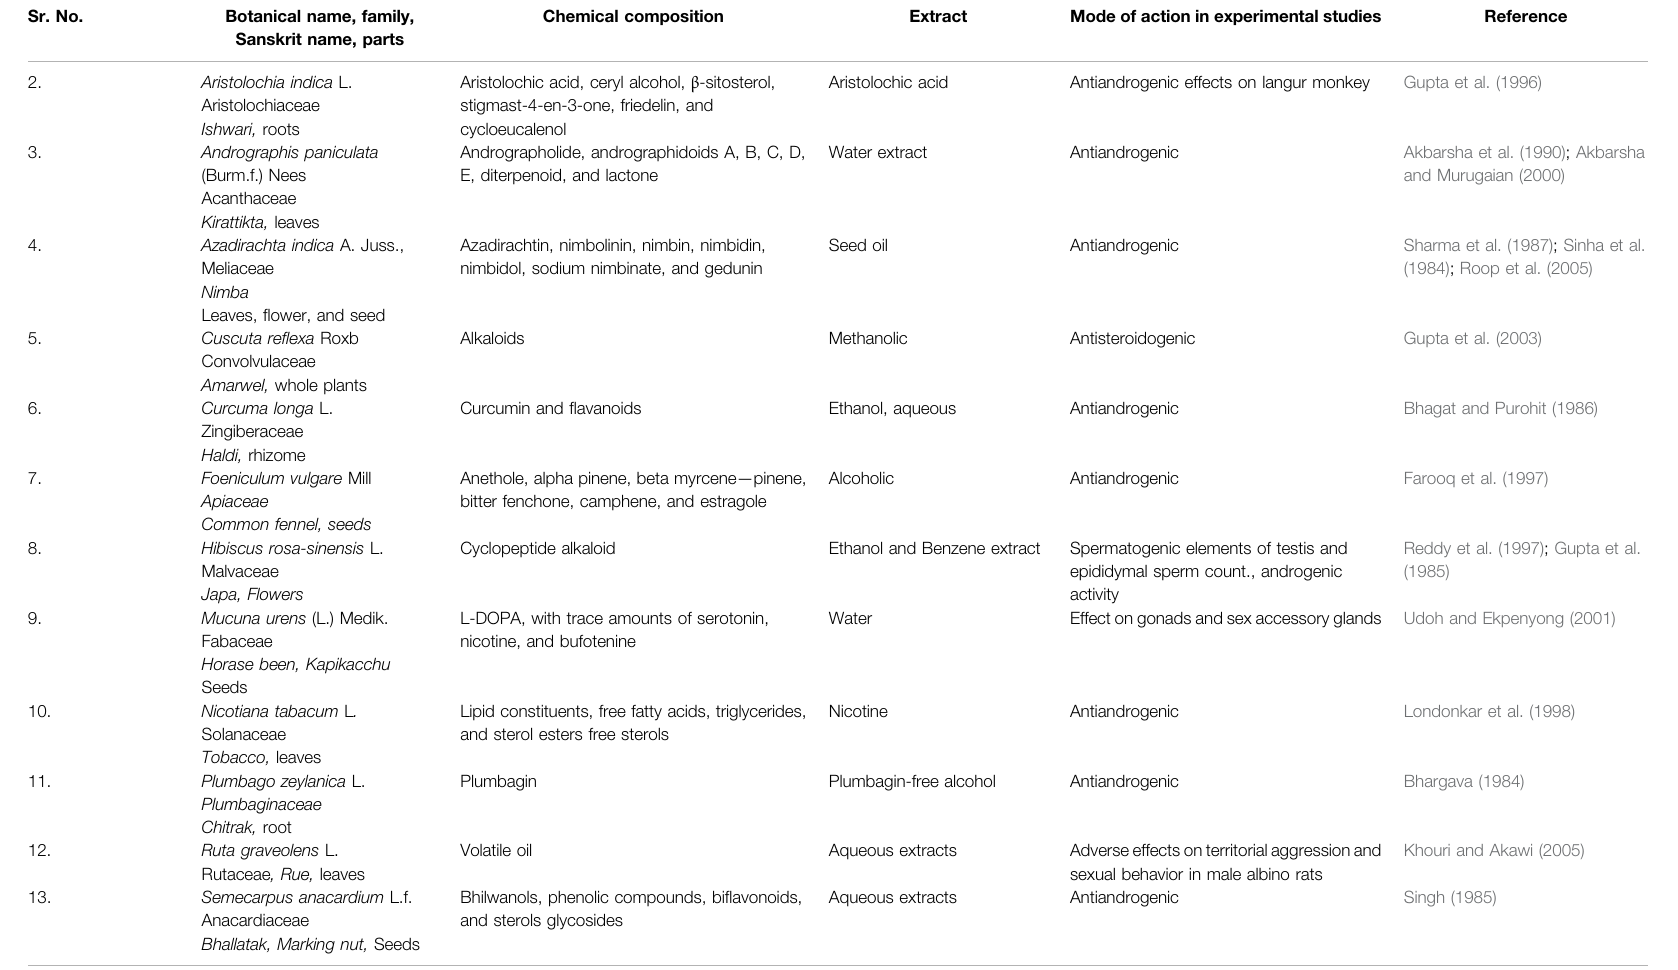
TABLE 2 | ( Continued ) Medicinal plants and their phyotoconstituents validated for various female/male contraceptive activities. Different contraceptive activities studied on medicinal plants could be categorized as follows. Female contraceptive activities: (2A) anti-implantation activity, (2B) aborti fi cation, (2C) antifertility, (2D) antiovulatory, and (2E) antiestrogenic activity. Male contraceptive activities: (2F) antispermatogenic, (2G) spermicidal, and (2H) antiandrogenic